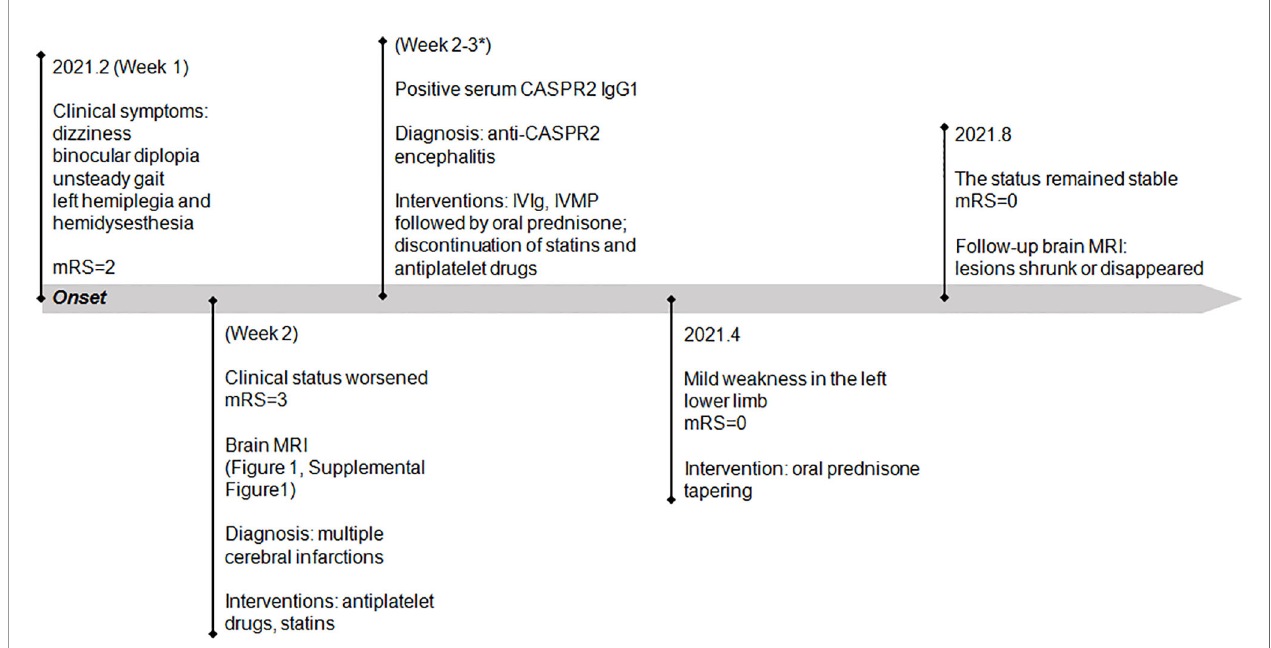
FIGURE 2 | Timeline of patient 1 with relevant data of the episodes and interventions. *This admission. mRS, modi fi ed Rankin scale; IVIg, intravenous immunoglobulin; IVMP, intravenous